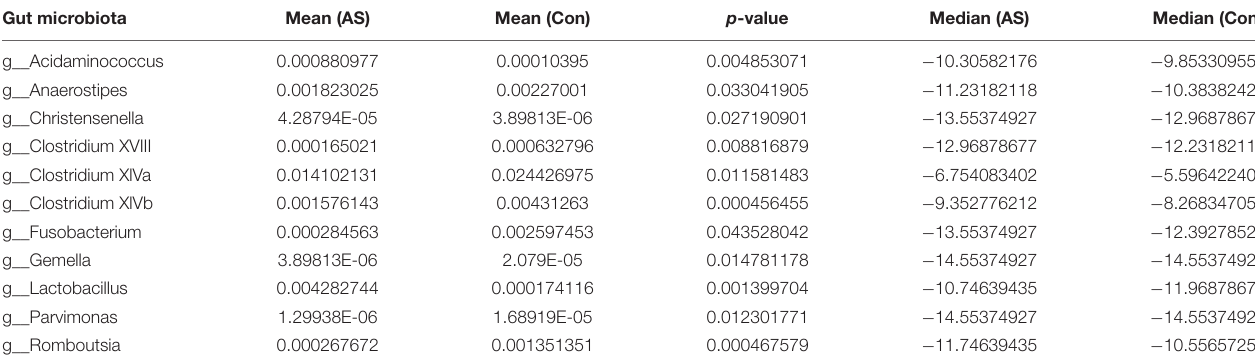
TABLE 2 | Differentially enriched gut microbiota from genera